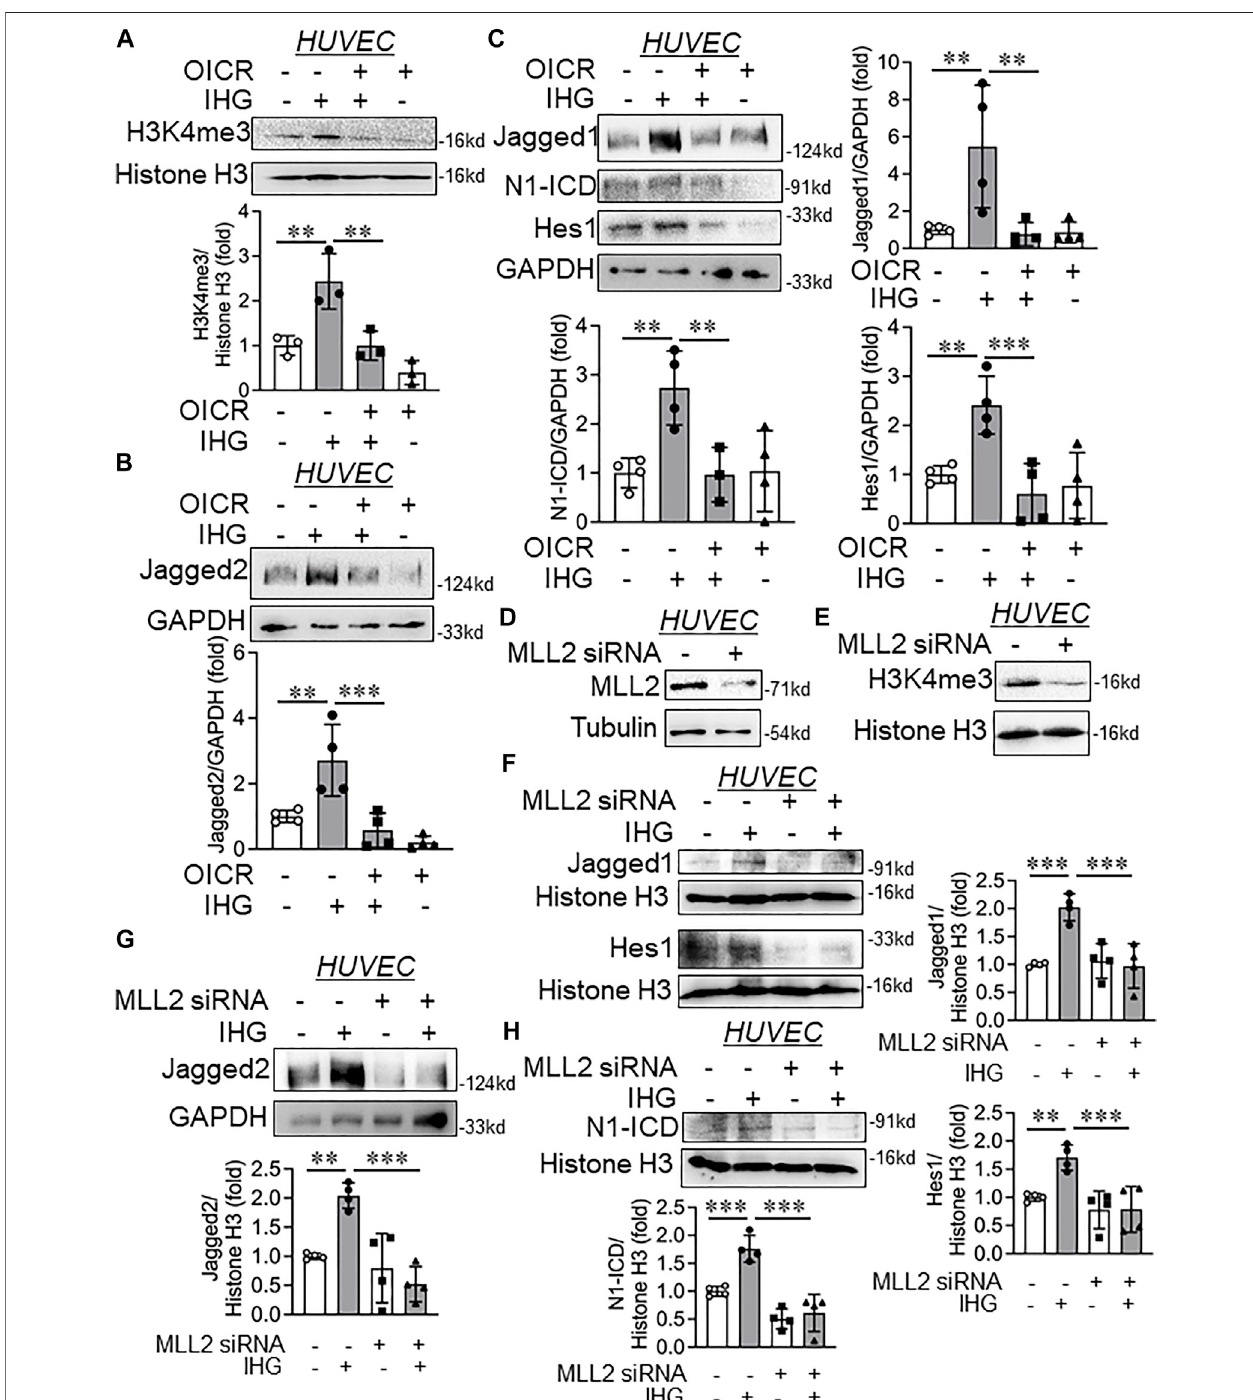
FIGURE4| CatalyticinhibitionorsiRNA-mediatedknockdownofMLLblockedintermittenthigh-glucose-dependentincreaseinJagged1andJagged2expression and further attenuating Notch activation. (A – D) Immunoblot analysis of HUVEC lysates collected from cells treated with intermittent high glucose in combination with OICR-9429 and probed for H3K4me3 ( A , n =3), Jagged2 ( B , n = 4), Jagged1 ( C , n = 4), N1-ICD ( C , n = 4), Hes1 ( C , n = 4) along with densitometry quanti fi cation. (D , E) HUVEC were transfected with MLL2 siRNA by following lipofectamine 2000 protocol followed by immunoblot to detect MLL2 ( D , n = 3) and H3K4me3 ( E , n = 3). (F – H) Immunoblot analysis of HUVEC lysates collected from cells transfected with MLL2 speci fi c siRNA followed by challenging with intermittent high glucose and probedforJagged1( F , n =4),Jagged2( G , n =4),N1-ICD( H , n =4),Hes1( F , n =4)alongwithdensitometry quanti fi cationoftheblots.Valuesrepresent themean±SD. ** p < .01, and *** p < .001, by the two-stage linear step-up procedure of Benjamin, Krieger, and Yekutieli test.